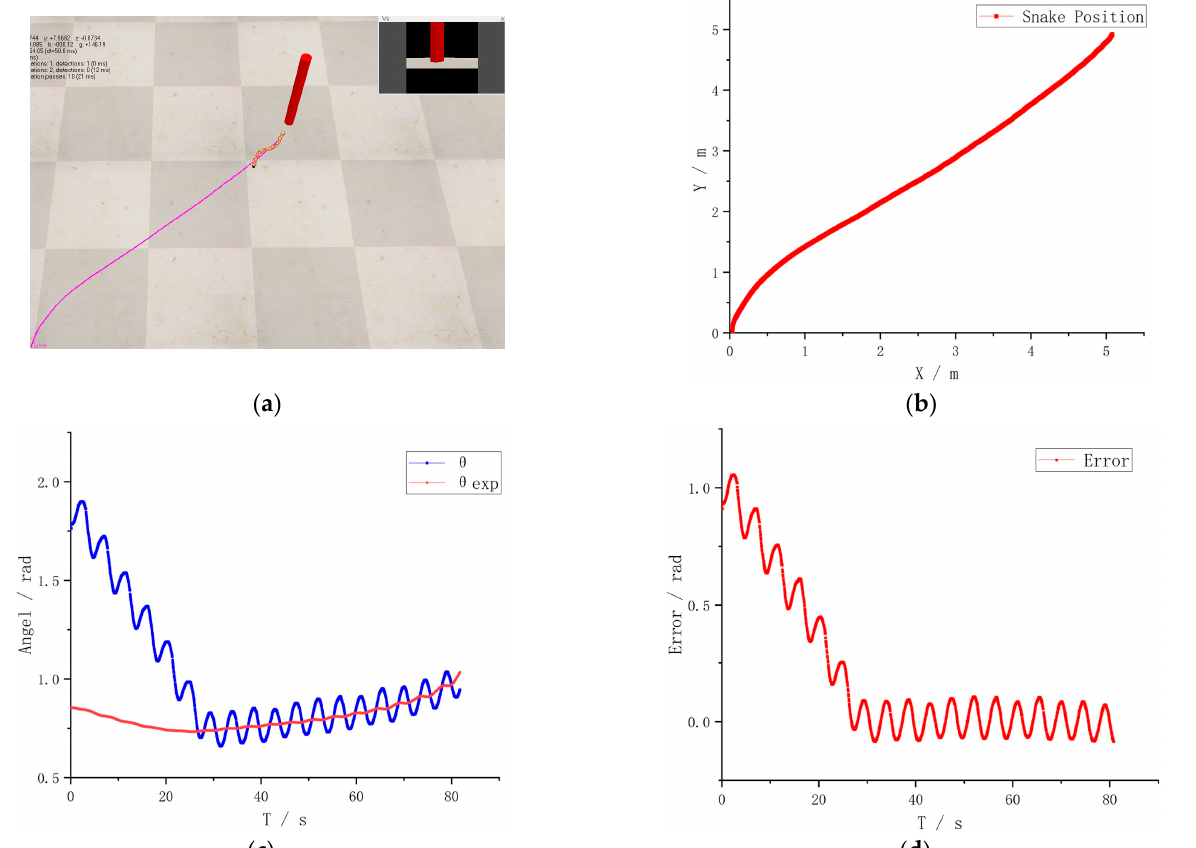
Figure 12. Simulation experiment results of target tracking control: ( a ) The trajectory of snake robot under tracking control; ( b ) Snake robot mass centric coordinates; ( c ) Desired direction angle and actual direction angle curve; ( d ) The error curve of the direction angle of snake robot.